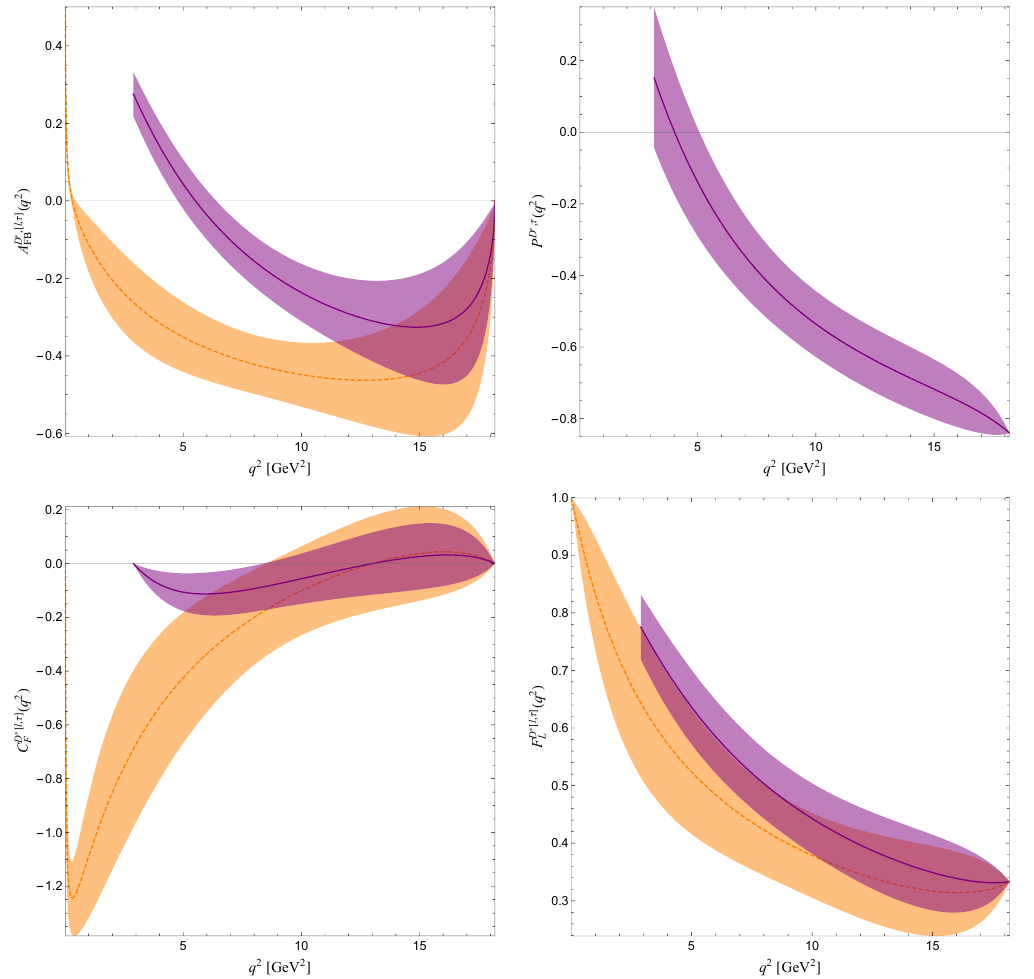
Figure 9 . Angular observables de(cid:12)ned in (3.12) with errors for B c ! D (cid:3) ( l; (cid:28) )(cid:22) (cid:23) stands for light leptons, a case depicted by a dashed-line/area in orange, whereas the case with the (cid:12)nal (cid:28) state is depicted in